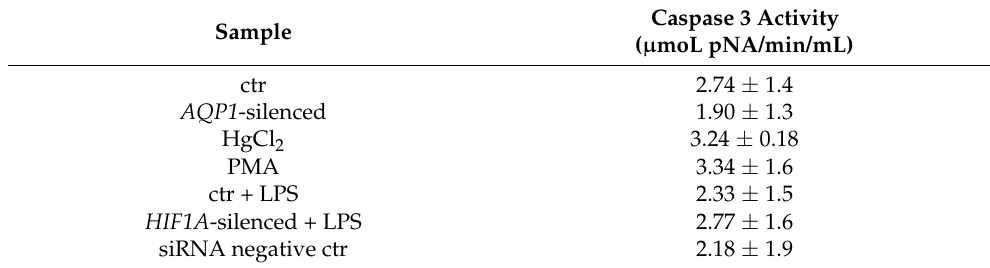
Figure 3. ( A ) Caspase 3 activity, ( B , C ) Time-course of wound healing of HPMECs. ( A ) In order to examine apoptosis in HPMECs, caspase 3 activity was measured in untreated HPMECs (ctr), AQP1 - silenced HPMECs, HPMECs exposed to 0.3 mmoL/L HgCl 2 for 5 min, HPMECs exposed to 100 nM PMA for 2 h, LPS-exposed HPMECs (ctr + LPS), LPS-exposed HIF1A -silenced HPMECs and HPMECs transfected with a universal scrambled negative control siRNA duplex. Data are presented as boxes. Each box represents the mean values and the bars represent the standard deviation values. Analysis was performed by one-way ANOVA followed by Kruskal Wallis. Results from 3 independent experiments. ( B , C ) Time-course representation of the percentage of wound closure measured in untreated HPMECs (yellow line with circles), LPS-exposed HPMECs (pink line with squares), HIF1A -silenced HPMECs exposed to LPS (green line with triangles), and HP- MECs transfected with a universal scrambled negative control siRNA duplex (blue line with circles). **, p < 0.01 compared to untreated cells. Analysis was performed by 2-way ANOVA followed by the Wilcoxon test. Results from 3 independent experiments. Table 1. Caspase 3 activity in